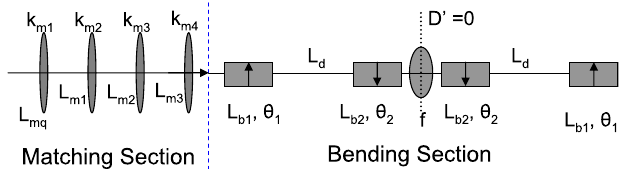
FIG. 3. (Color) First order achromatic bend comprised of four dipoles and one quadrupole. The two inner dipoles have opposite sign as compared to the two outer ones. Since j (cid:10) 2 j < j (cid:10) 1 j , the beam is deflected by the whole system. The matching section shown to the left is used to match (cid:4) and (cid:1) according to Eq. (5).